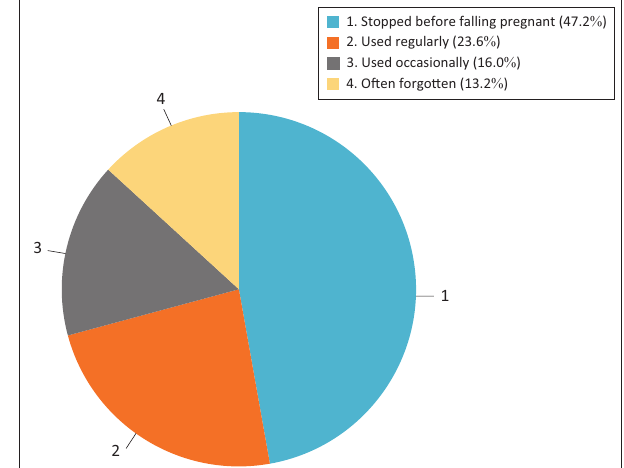
TABLE 3: Comparison of sociodemographics and reasons for termination of pregnancy: Expressed in p -values. Socio-demographic characteristic